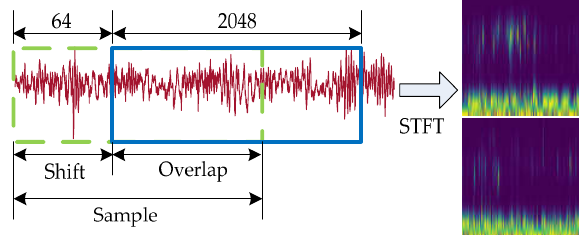
Figure 5. Data preprocess using data augmentation with overlap.